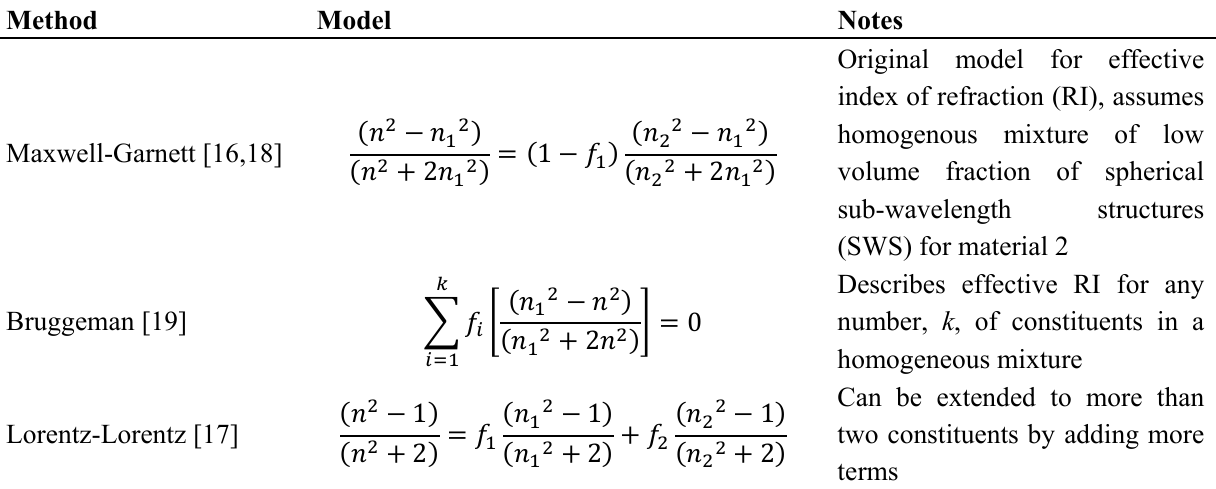
Table 1. Common effective medium approximations (EMA)